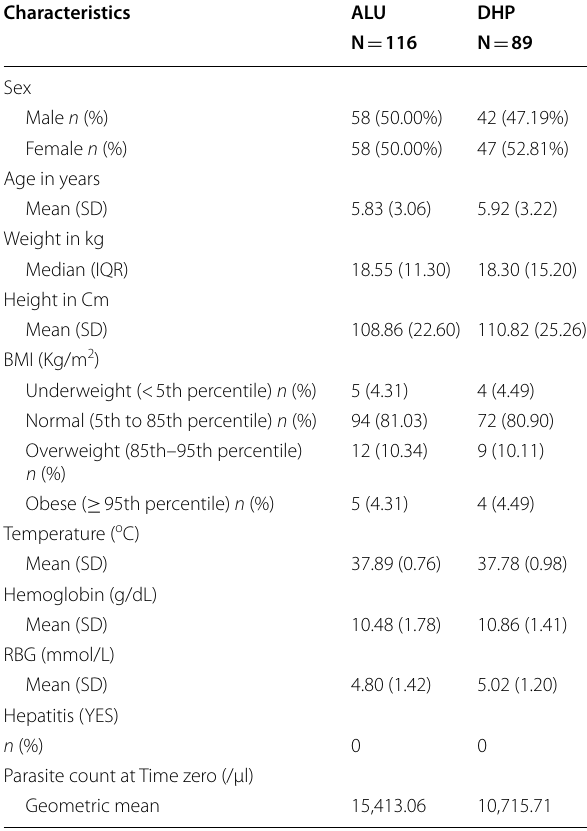
Table 1 Baseline characteristics of the study participants